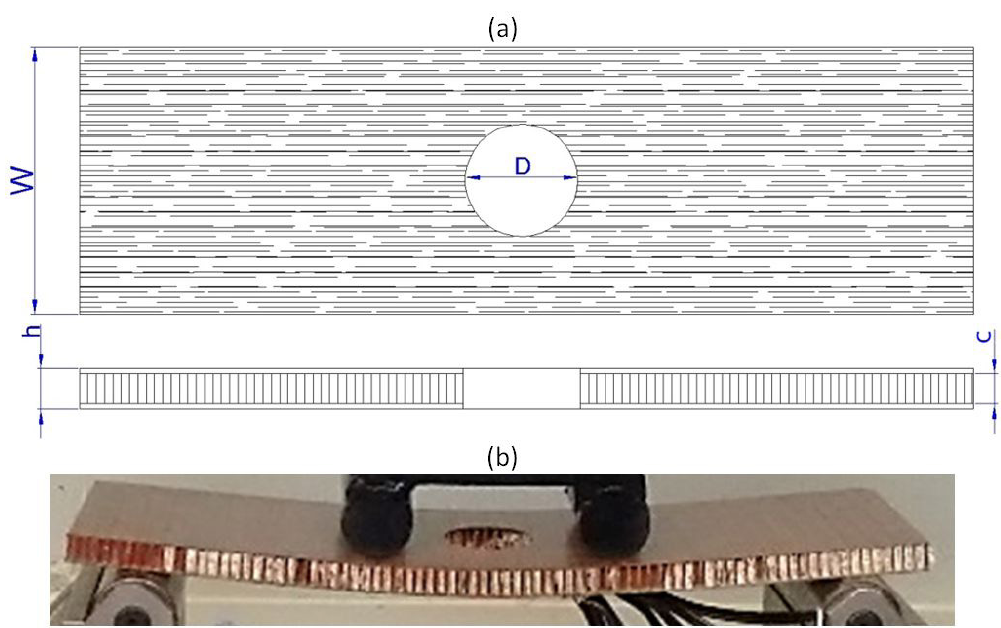
Figure 1. Test specimen of a sandwich laminate with a hole for the four-point bending testing (a) Schematic representation (b) Test Specimen.